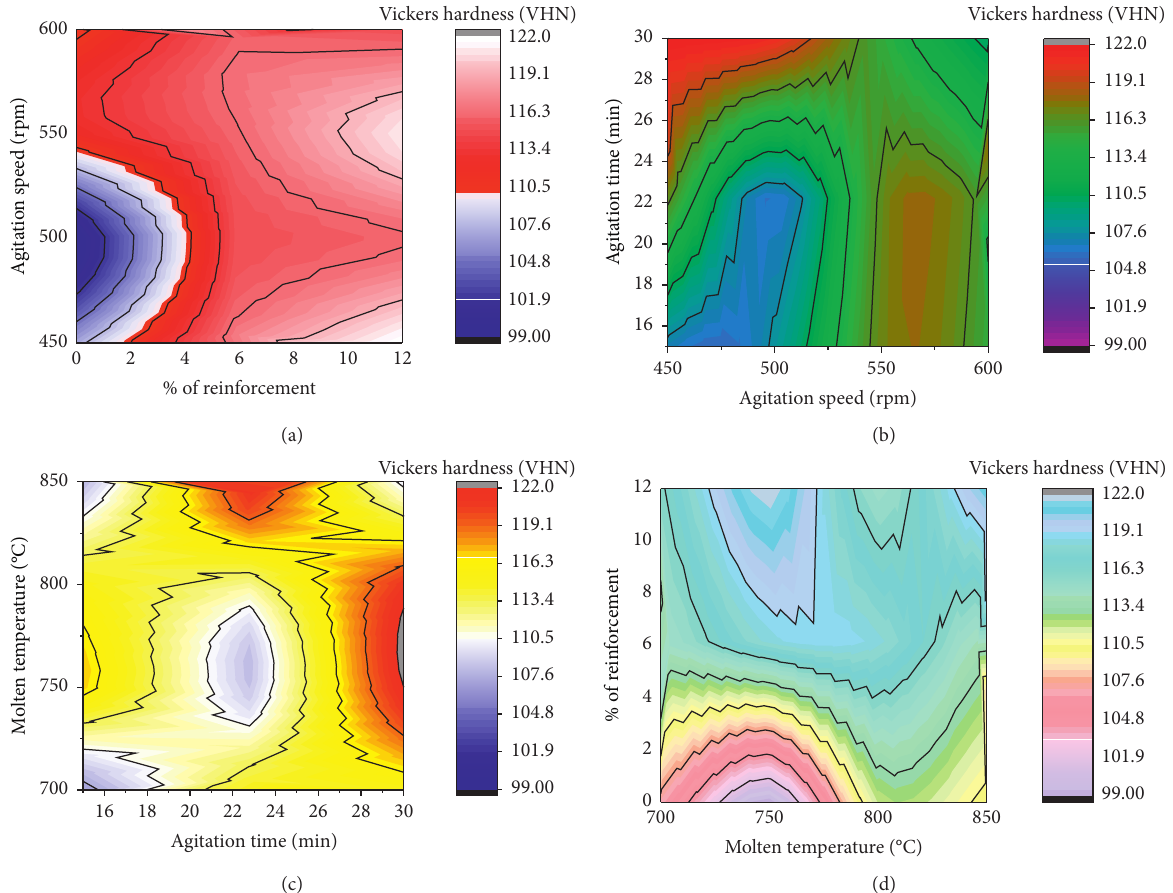
Figure 15: (a) Contour plot: % of reinforcement. (b) Contour plot: agitation speed. (c) Contour plot: agitation speed. (d) Contour plot: molten temperature versus % of